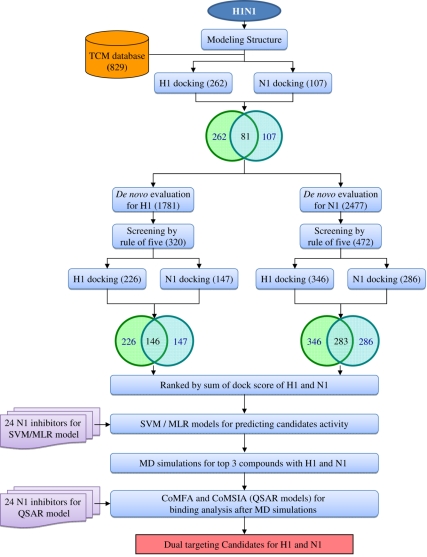
The flowchart of dual-target H1N1 experimental procedures.